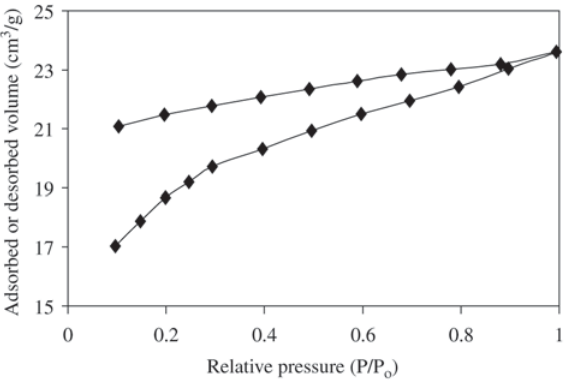
Figure 3. Pore size distribution for porous silica obtained via con- ventional (C) heating and via microwave (M) heating.